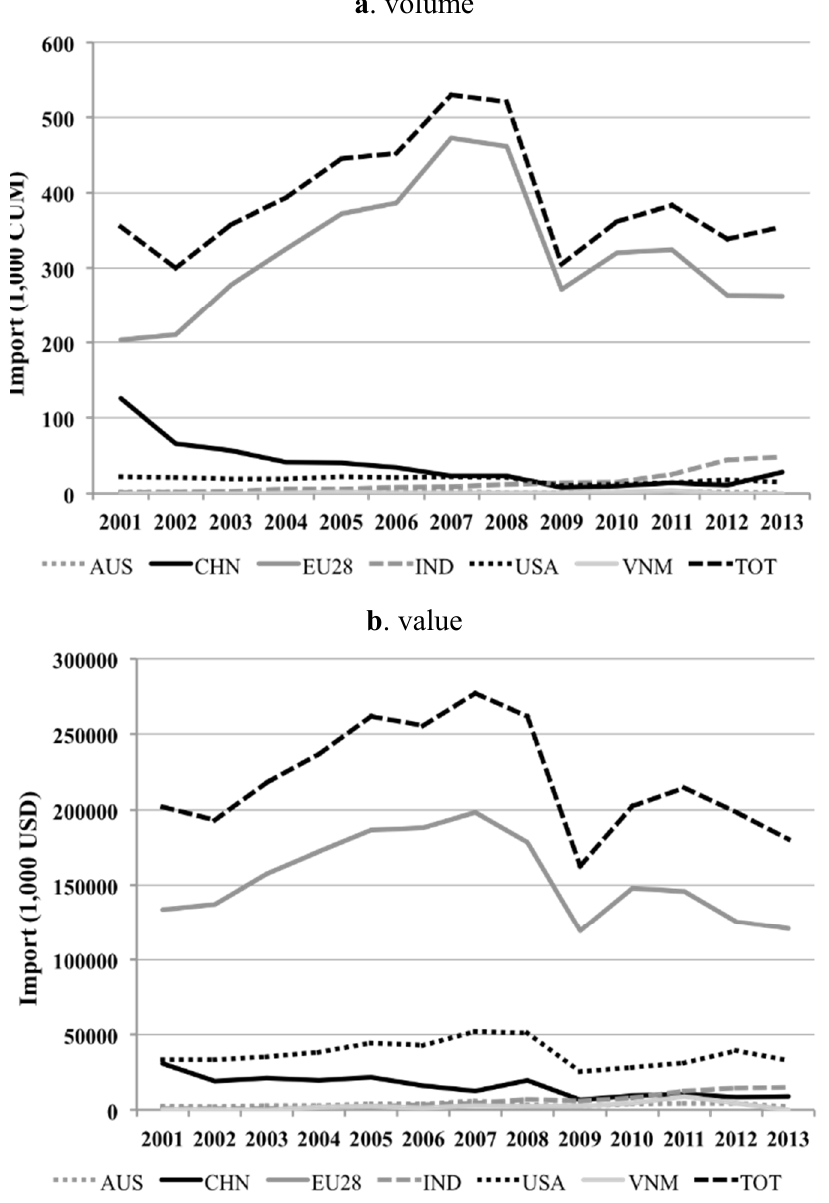
Figure 4. Imports of tropical veneers—in volume ( a ) and value ( b )—by selected countries (2001–2013). Source: own elaboration from